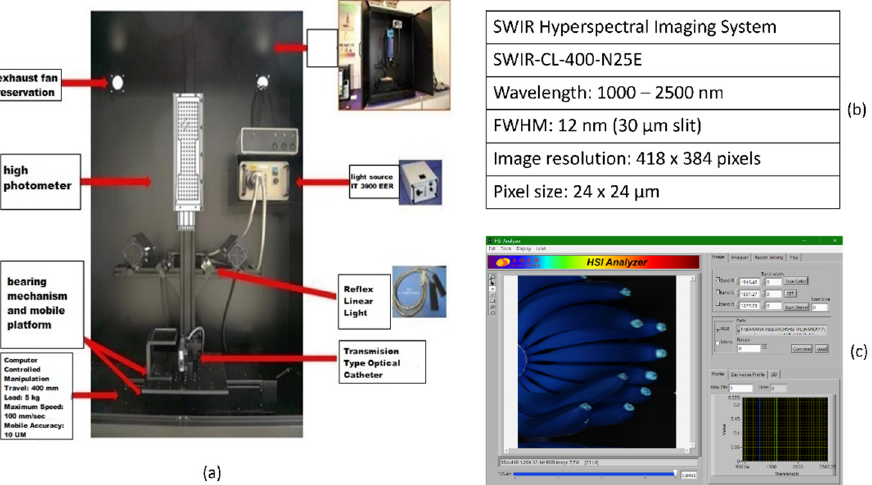
Figure 2. Experimental setup for obtaining Hyperspectral data, ( a ) HS camera setup, ( b ) HS camera specification, and ( c ) software for processing and capturing HS data and images.